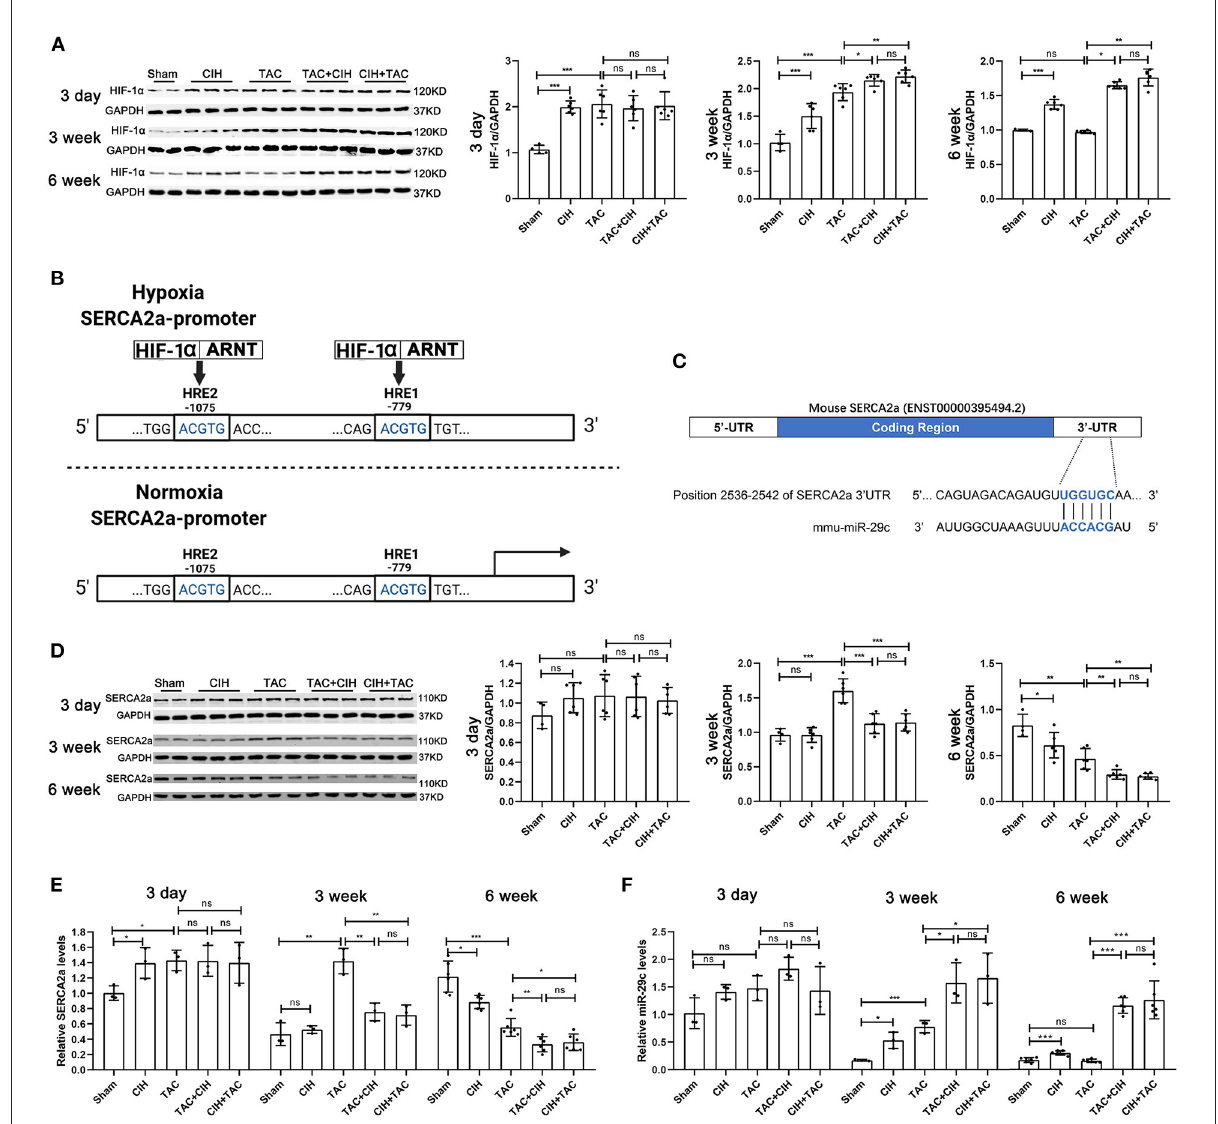
FIGURE3 CIH exposure maintains long-term elevations in the expression of HIF-1 α and induces a sustained decrease in SERCA2a levels and a sustained increase in miR-29c levels in the hearts of mice subjected to TAC. (A) Western blot analysis of HIF-1 α expression in the heart in all groups at day 3, week 3 and week 6. n = 6 (sham group n = 4); * p < 0.05, ** p < 0.01, *** p < 0.001. (B) Schematic diagram of the competitive binding of HIF-1 to the SERCA2a promoter region under hypoxic conditions. (C) Schematic representation of the miR-29c and SERCA2a mRNA binding sites. (D) Western blot analysis of SERCA2a expression in the heart in all groups at day 3, week 3 and week 6. n = 6 (sham group n = 4); * p < 0.05, ** p < 0.01, *** p < 0.001. (E) Real-time PCR analysis of relative SERCA2a levels in heart tissue at day 3, week 3 and week 6. n = 3 (week 6 n = 6); * p